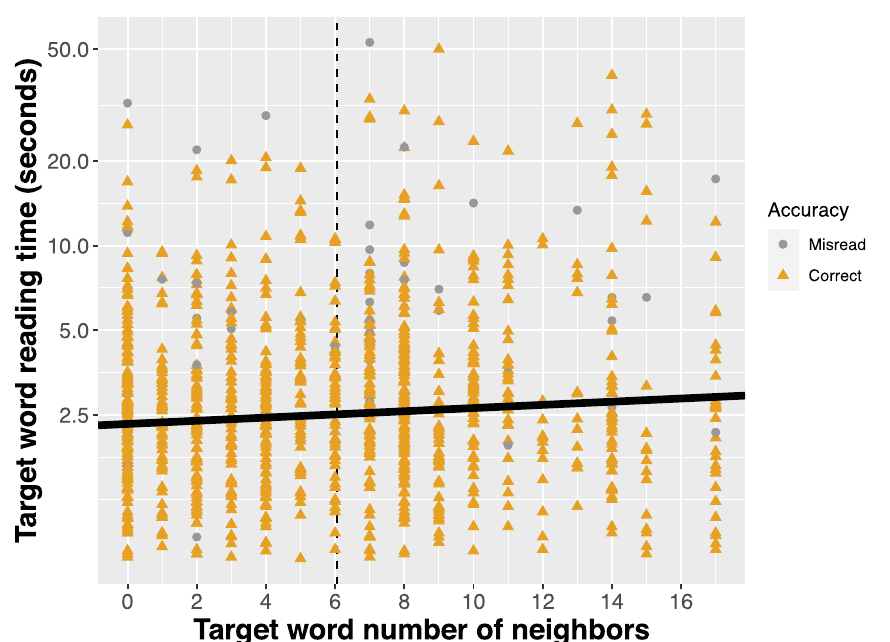
Figure 5. Effect of neighborhood size (N) on word reading time. Data for both well-read words (yellow triangles) and misread words (grey circles) are plotted but the fitted line extracted from the LME model (solid black) only considers the words correctly read. The black dotted line marks N mean